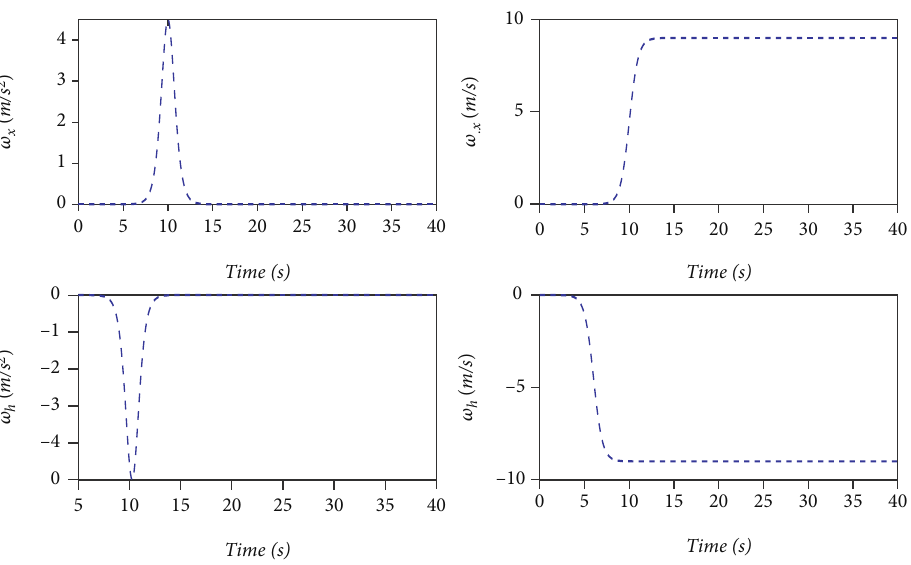
Figure 6: The curves of wind disturbance.